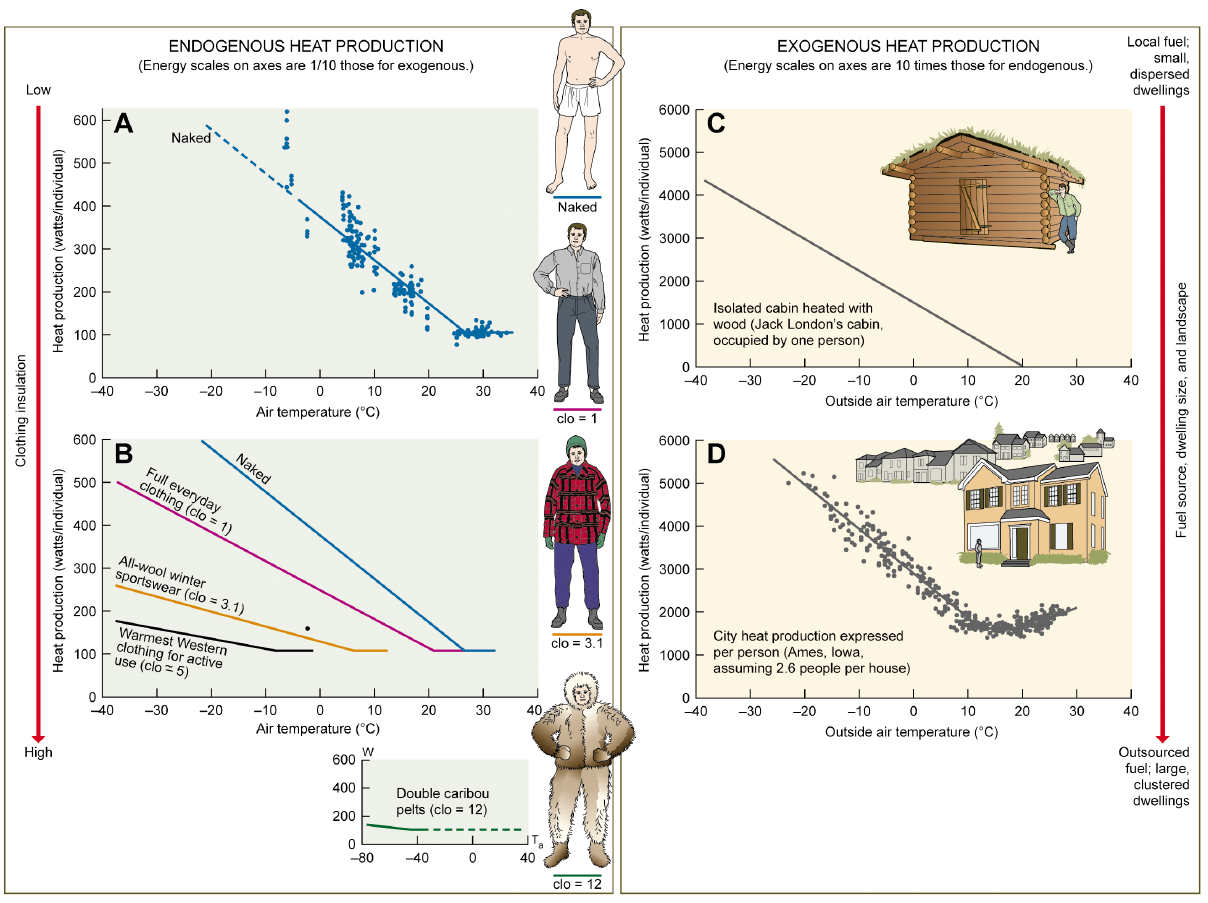
Figure 4. Per capita energy demands of human thermoregulation by endogenous and exogenous heat production. (A) Meta-analysis of all pertinent data available on thermoregulation in naked people from Fig. 3. (B) Metabolism- T a curves for clothed people (equations and derivation in Table S2). Only a narrow thermoneutral zone (TNZ) is shown in each plot because a person would not elect to stay in the specified clothing at highly elevated T a . Dot is a direct measurement on a man in winter sports clothing [16]. (C) The rate of addition of heat to the interior of Jack London’s Yukon cabin required to maintain an interior temperature of 20 u C (Table S3): W/individual = 2 74.4 ( T a – 20 u C). A cabin heated with hand-cut wood and devoid of electricity has no TNZ because the fire would be allowed to go out at high outside T a . (D) Data from Fig. 2 for Ames, IA, a city with median properties, assuming 2.6 people per household [40]. Regression below thermoneutrality: W/individual = 2863 – 105 T a .